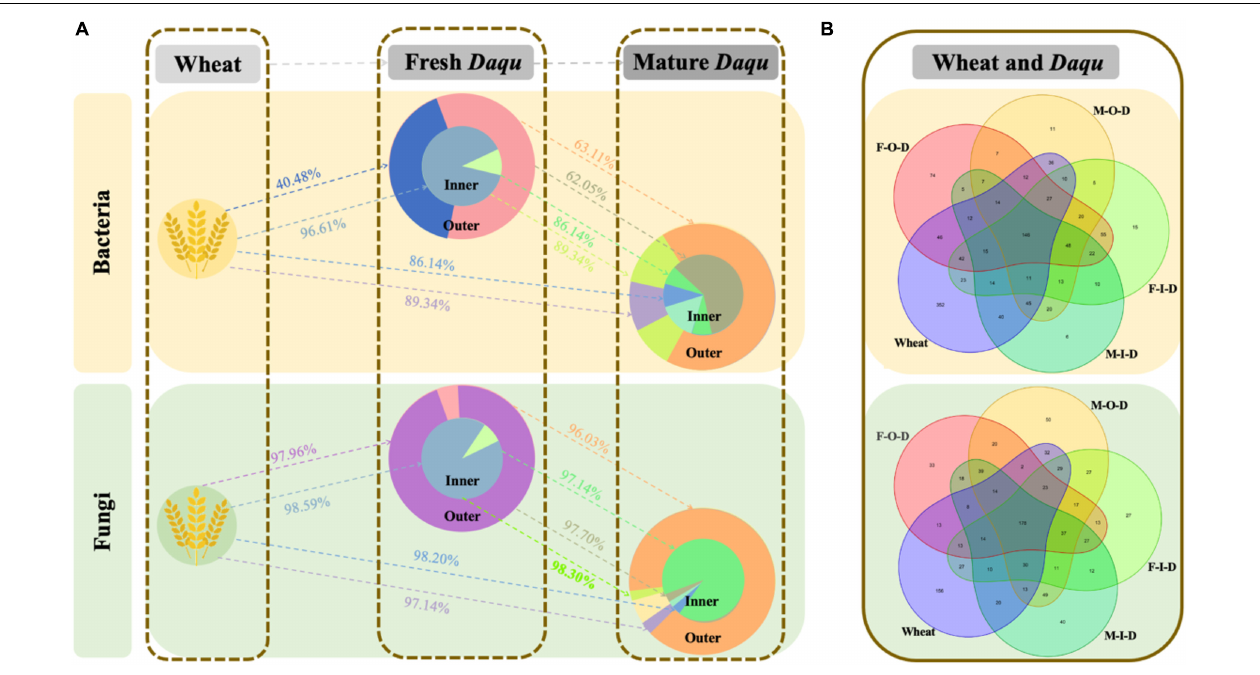
FIGURE 5 | SourceTracker results for the wheat and Daqu sample via SourceTracker. (A) Estimation of shift pathway and proportion. (B) Specific numbers of OTUs. The “ → ” represent microbiota shift direction. F-I-D: Inner of fresh Daqu ; F-O-D: Outer of fresh Daqu ; M-I-D: Inner of mature Daqu ; M-O-D: Outer of mature Daqu